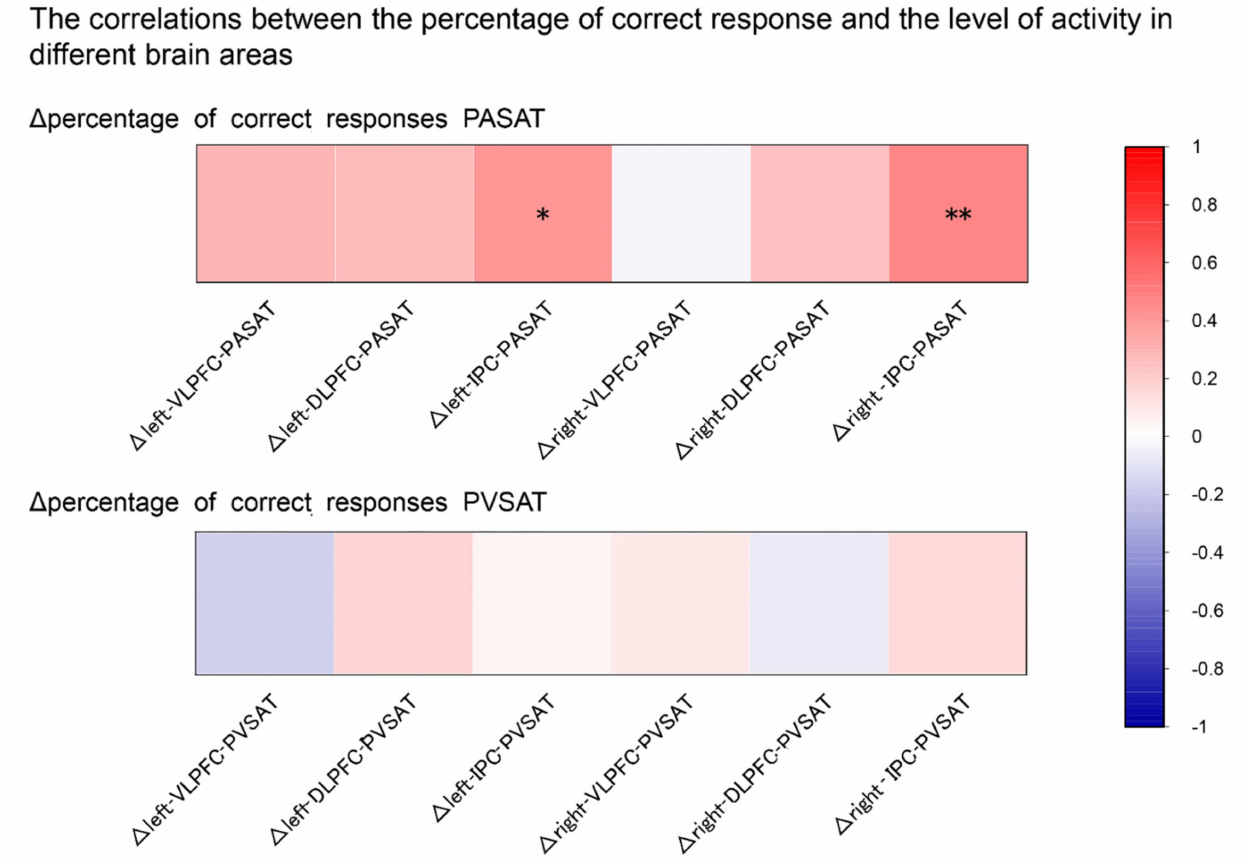
Figure 6. Correlation analyses between ∆ percentage of correct responses in PASAT and PVSAT and ∆ Oxy-Hb concentration in all ROIs. The upper row indicates the correlations between ∆ percentage of correct responses in the PASAT and ∆ Oxy-Hb concentration in all ROIs. The lower row indicates the correlations between ∆ percentage of correct responses in the PVSAT and ∆ Oxy-Hb concentration in all ROIs. The color bar shows the correlation coefficient. VLPFC, ventrolateral prefrontal cortex; DLPFC, dorsolateral prefrontal cortex; IPC, Inferior parietal cortex; PASAT, Paced Auditory Serial Addition Test; PVSAT, Paced Visual Serial Addition Test. * p < 0.05, ** p <